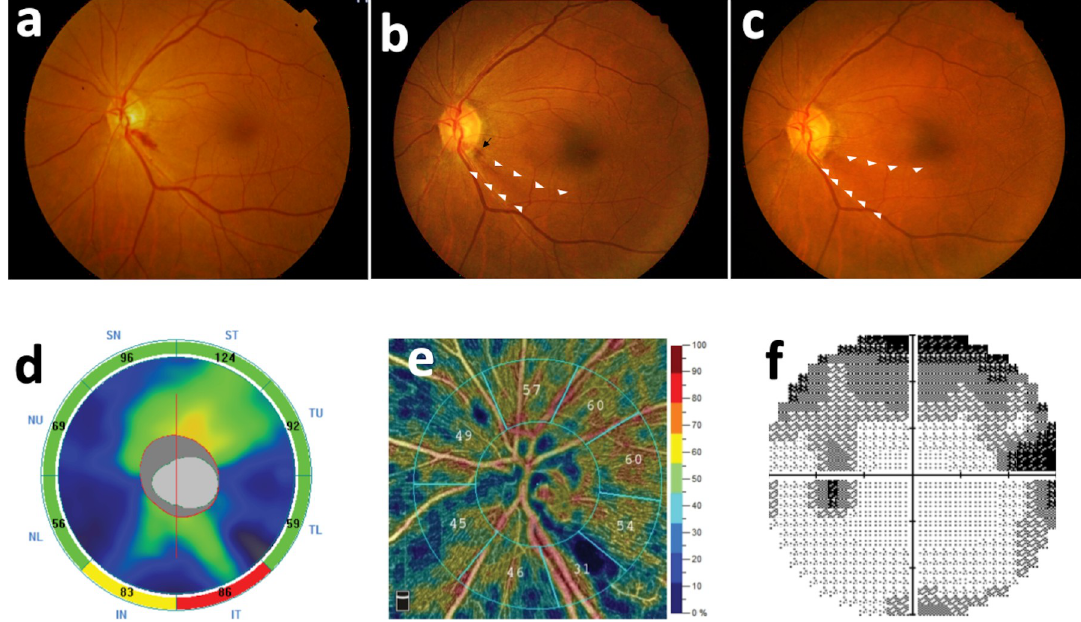
Fig 2. A 71-year-old woman with peripapillary pigment formation subsequent to resolution of DH after a 6-year follow-up. (a) This patient initially presented with peripapillary DH at a 5 o’clock position. (b) 2 years later, pigment formation (arrow) with an inferotemporal RNFL defect (white arrowheads) developed at the prior site after the resolution of DH. (c) 4 years later, the pigmentation remained and the RNFL defect progressed (white arrowheads). (d) & (e) Optical coherence tomography and angiography revealed RNFL thinning and decreased VD in the inferotemporal area corresponding to findings on a color fundus photo. (f) Humphrey visual field examination disclosed superior arcuate scotoma.